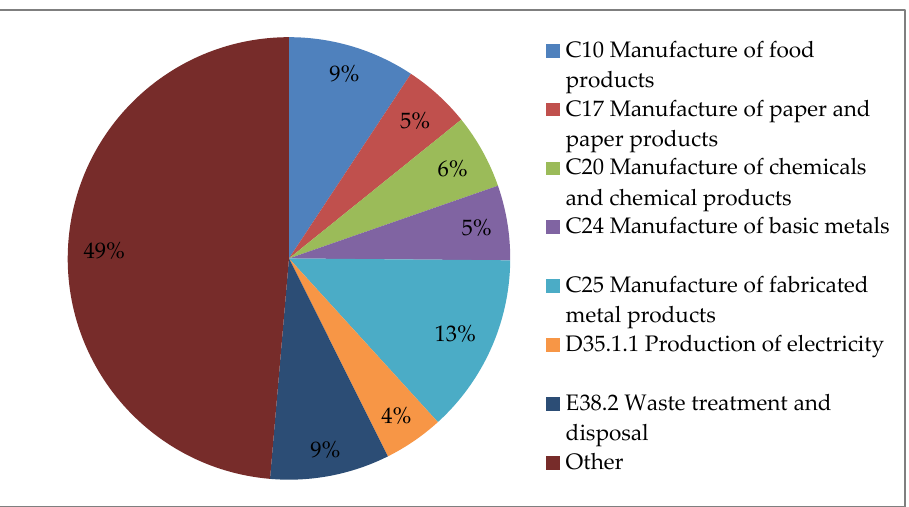
Figure 10. Greek participants type profile.